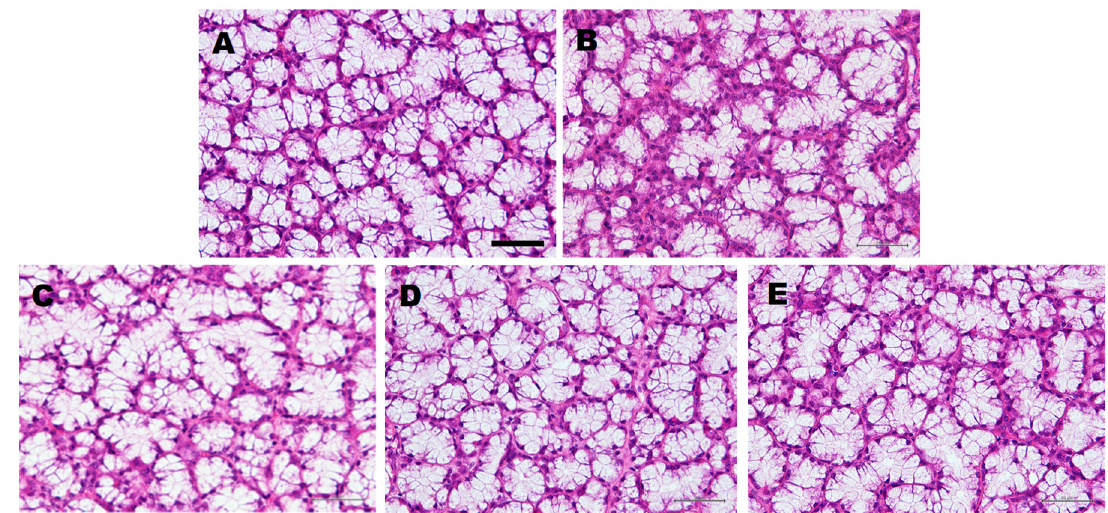
Figure 1. Effect of water-, Leu 57 -Leu 58 -His 59 -Lys 60 (LLHK-), Leu 58 -His 59 -Lys 60 (LHK)-, or His 59 -Lys 60 (HK)-treatment on the morphology of sublingual glands (SLGs). The younger rats were given water ( A ). The older rats were given water- ( B ), LLHK- ( C ), LHK- ( D ), or HK- ( E ) for 1 month. Bar, 50 µm.